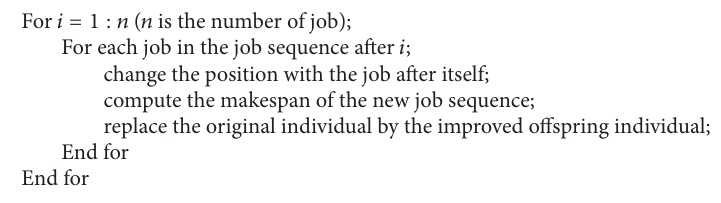
Algorithm 3: The basic flowchart of IIS local search.